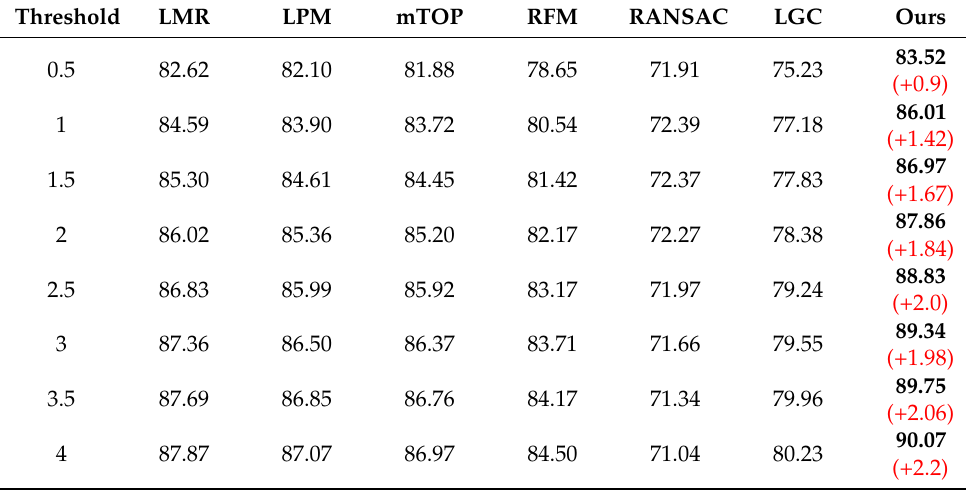
Table 3. The average F1-score (%) with different thresholds τ for all the image pairs in Figure 8. The best results are in bold. The red numbers in the brackets indicate the improvement between the best and the second best results.